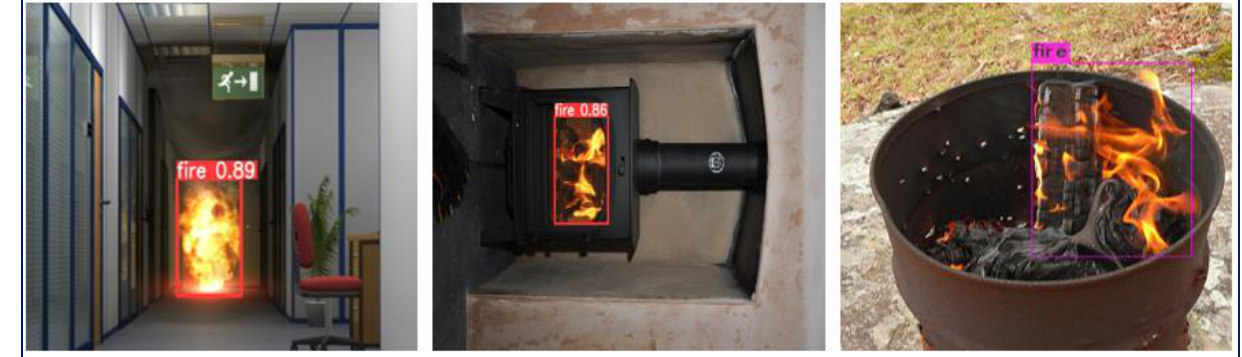
Figure 4. Visible experiment results in forest fire scenes.